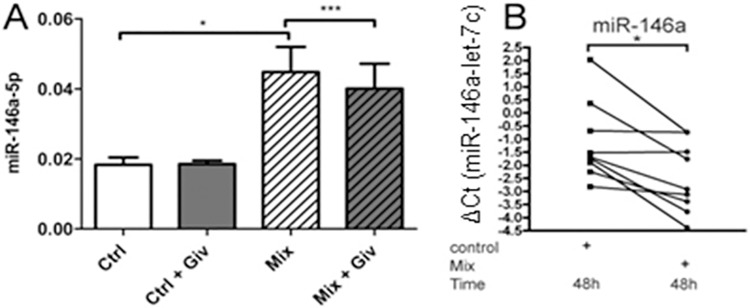
KDACi reduces cytokine-induced expression of miR-146a-5p in human islets.(A) Human islets from three individual necro-donors were treated with or without 500 nM Givinostat (Giv) 1 h prior to addition of 300 pg/ml IL-1β, 10 ng/ml IFN-γ, and 10 ng/ml TNF-α (Mix) or no cytokines (Ctrl) for 24 h. miR-146a-5p expression was measured with qRT-PCR and normalized to the geometric mean of the housekeeping miRs miR-103a and miR-423. Data are presented as mean ± SEM of 2-ΔCT. *p<0.05 (95% confidence interval = -0.04836 to -0.004574), ***p<0.001 (95% confidence interval = 0.004108 to 0.005359). (B) Human islets from nine individual necro-donors were left untreated (control) or treated for 48 h with a mixture of 5000 U/ml TNF-α, 750 U/ml IFN-γ, and 75 U/ml IL-1β (Mix). miR-146a-5p expression was analyzed by qRT-PCR and presented as ΔCT values after normalizing to let-7c. *p<0.05.